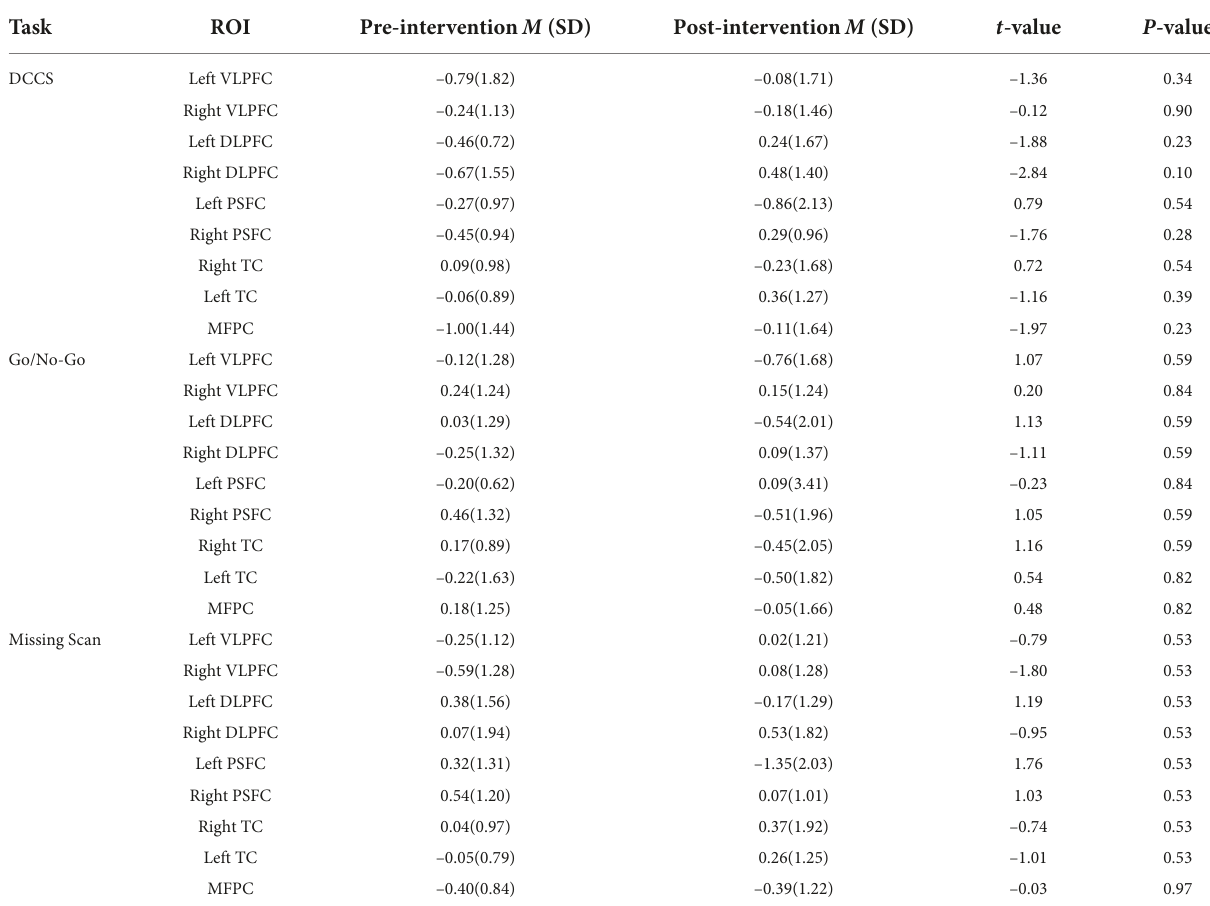
TABLE 6 Comparison of increases in HbO before and after the intervention for boys ( N =